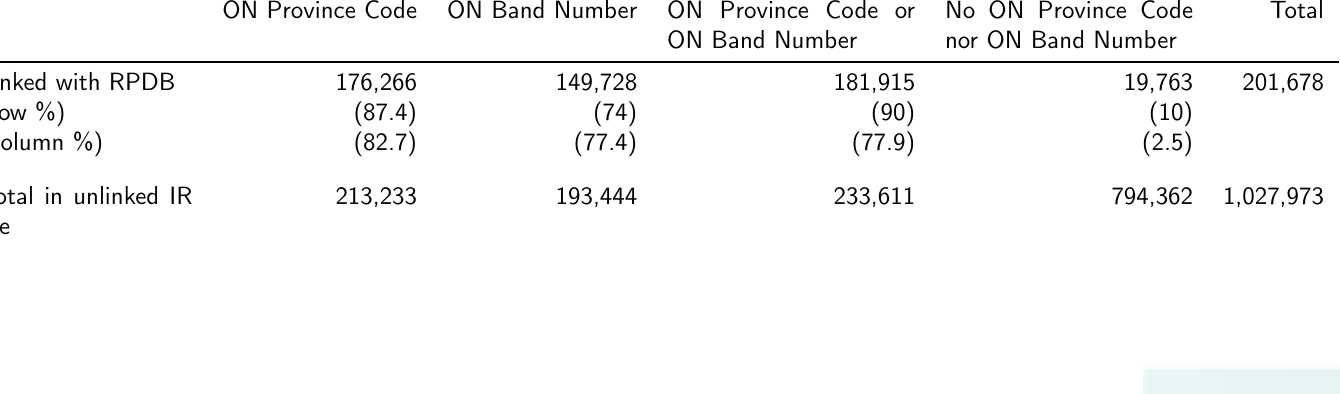
Table 3: Comparison of sources intending to capture First Nations population counts, by